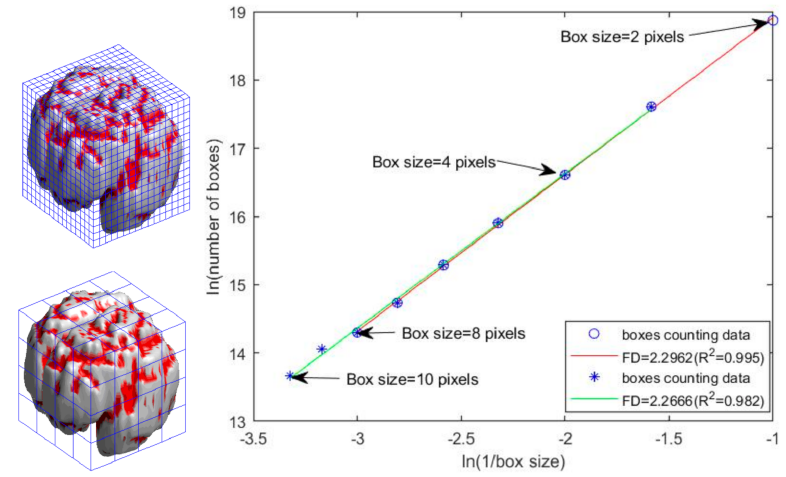
Figure 2. Computational procedure for FD estimation. Left: the smaller the box size, the larger the number of boxes counted, and vice versa. Right: log–log scatter plot, where the x and y axis denote the inverse of the box size and the number of boxes in the logarithmic scale,